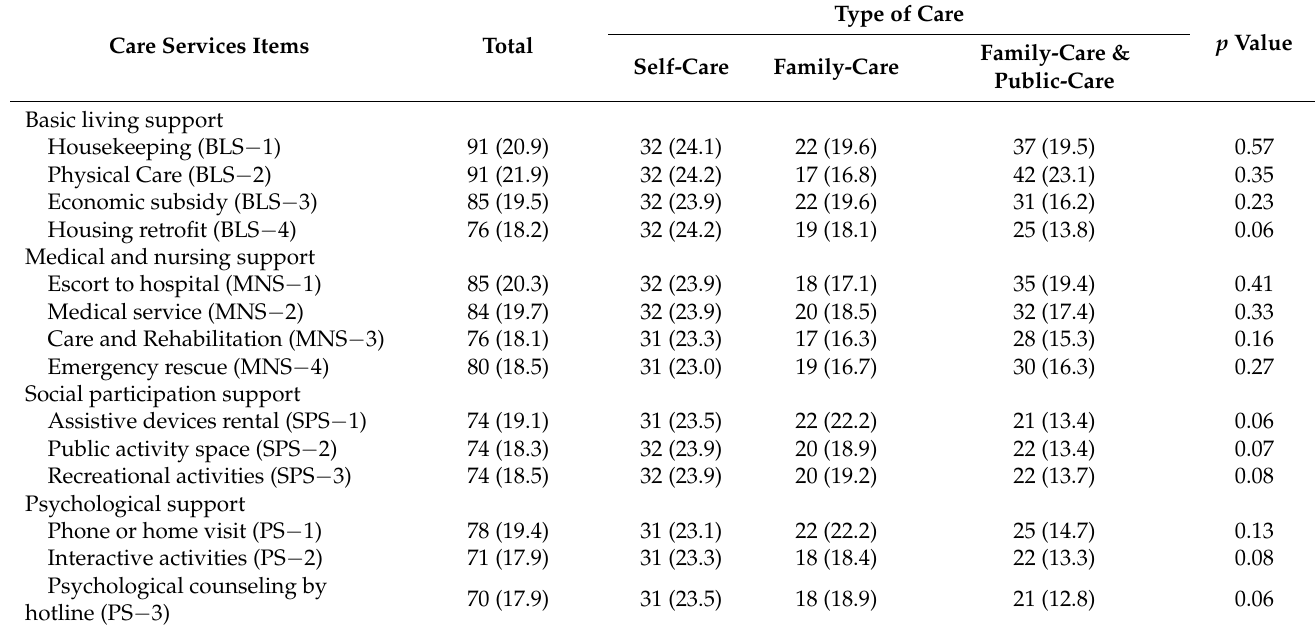
Table 5. Satisfaction of individual care needs for disabled elderly in different types of care.